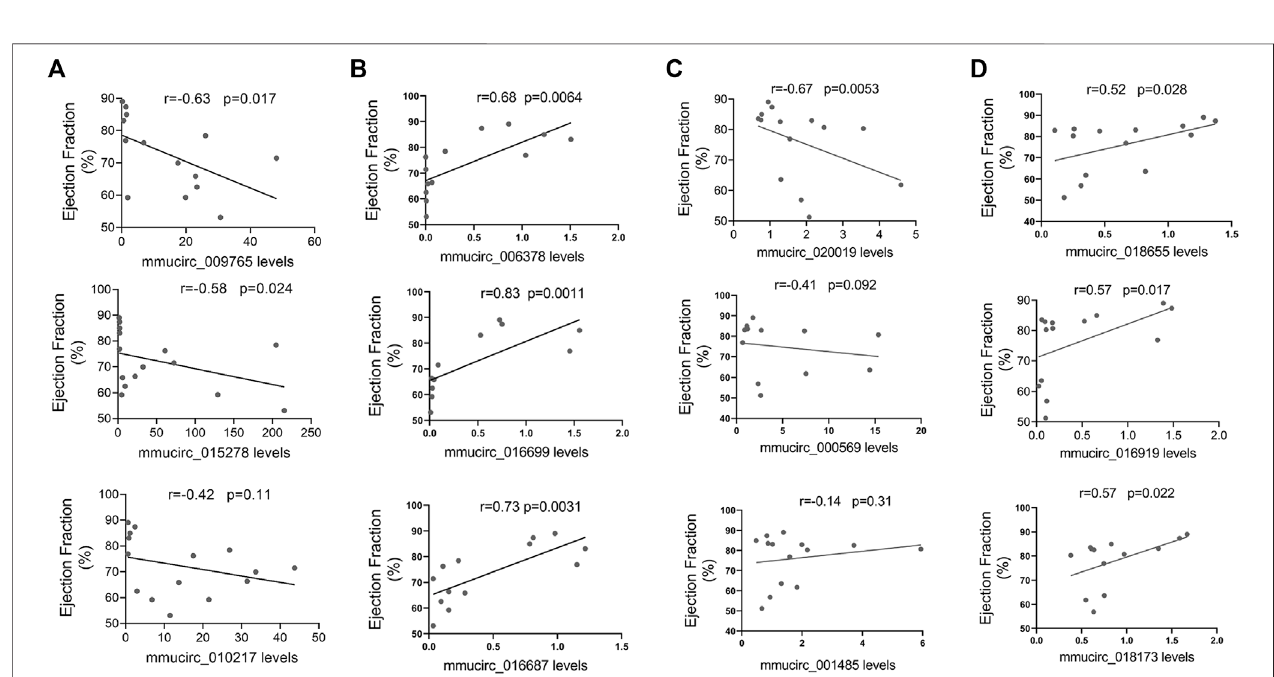
FIGURE 4 | Correlation between circRNAs expression levels and cardiac function. (A) The correlation between A/J-speci fi c upregulated circRNAs (mmucirc_009765, mmucirc_015278, mmucirc_010217) and cardiac function, N > 12. (B) The correlation between A/J-speci fi c downregulated circRNAs (mmucirc_006378, mmucirc_016699, mmucirc_016687) and cardiac function, N > 12. (C) The correlation between C57BL/6-speci fi c upregulated circRNAs (mmucirc_020019, mmucirc_000569, mmucirc_001485) and cardiac function, N > 12. (D) The correlation between C57BL/6-speci fi c downregulated circRNAs (mmucirc_018655, mmucirc_016919, mmucirc_018173) and cardiac function, N > 12.